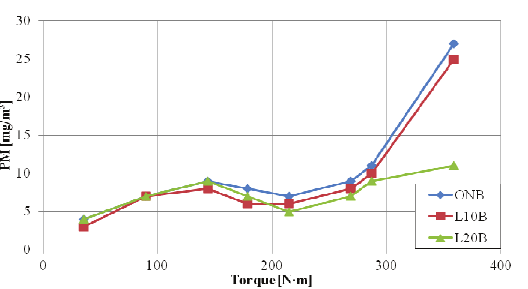
Fig. 7. PM for injection timing C and n = 1400 rpm